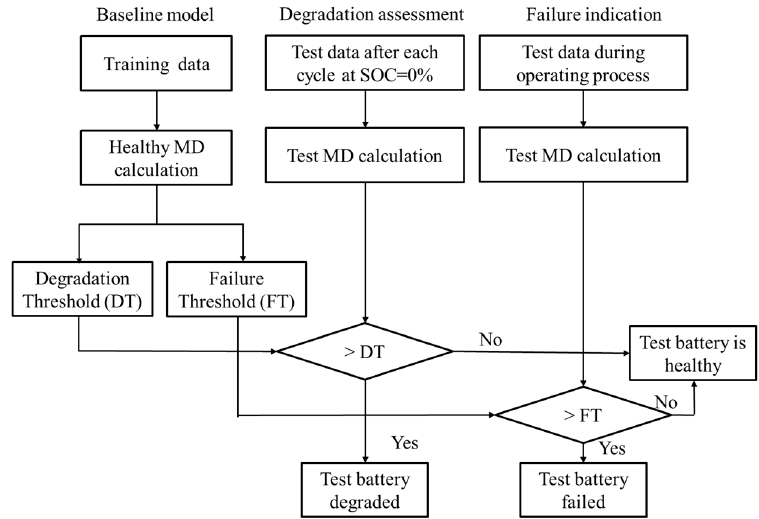
Figure 8. Developed battery health monitoring method.